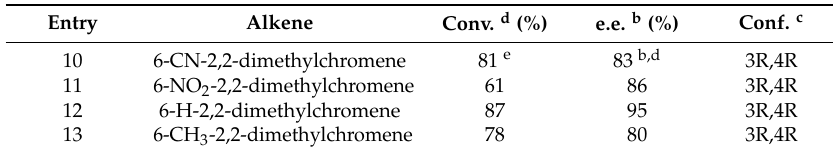
Table 2. Enantioselective epoxidation of alkenes with H 2 O 2 catalyzed by (salen)Mn(III) in H 2 O in the presence of AOE-14 as surfactant at 25 ˝ C. a